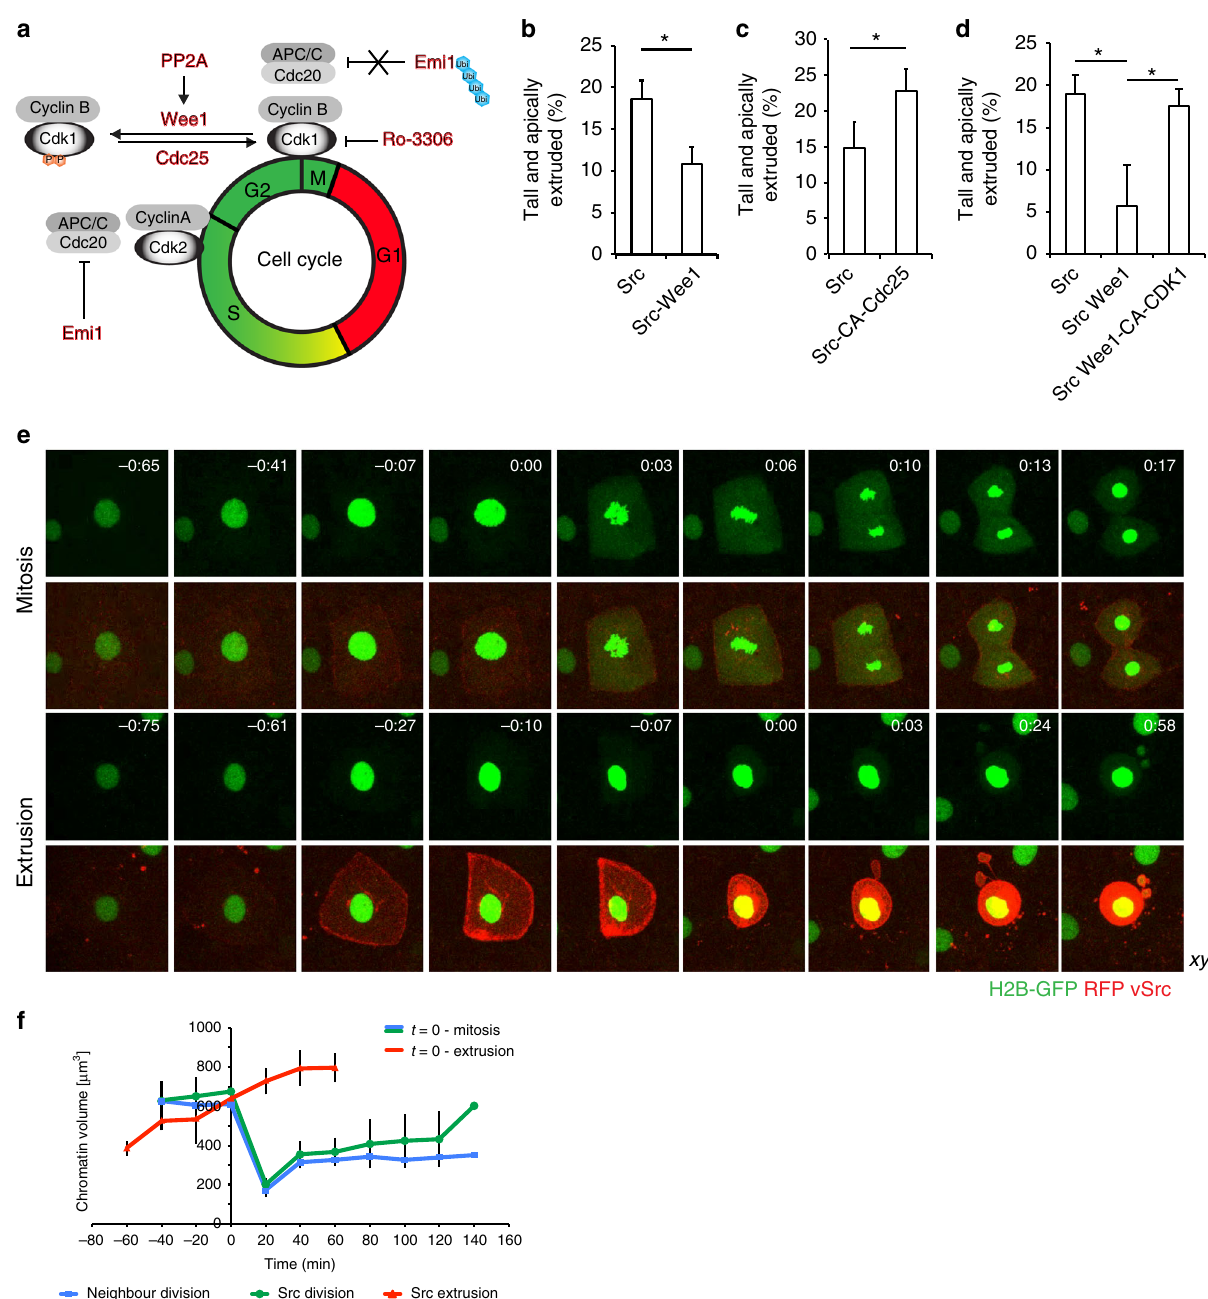
Fig. 3 vSrc-transformed cells extrude in early mitosis. a A schematic model of cell cycle regulation. Highlighted in red are the molecules whose roles in cell extrusion were tested in this work. b The effect of Wee1 expression on vSrc-driven extrusion. Embryos were injected with the following constructs: dUAS: EGFP-vSrc and dUAS:EGFP-vSrc;Wee1. Data represent the number of tall and extruded cells divided by the total number of GFP-positive cells. Data are mean ± s.d. of three independent experiments (total number of embryos: n Src = 21; n Src,Wee1 = 27). * P < 0.05 (Student ’ s t -test). c The effect of constitutively active Cdc25 on vSrc-driven extrusion. Embryos were injected with the following constructs: dUAS:EGFP-vSrc and dUAS:EGFP-vSrc;CA-Cdc25. Data are mean ± s.d. of three independent experiments (total number of embryos: n Src = 18; n Src,Cdc25 = 21). * P < 0.05 (Student ’ s t-test). d Constitutively active Cdk1 rescues Wee1 inhibition of vSrc-driven extrusion. Embryos were coinjected with the following constructs: dUAS:EGFP-vSrc alongside either dKrt18:myr- Cherry, dKrt18:Cherry-Wee1 or dKrt18:Cherry-Wee1;CA-Cdk1. Data are mean ± s.d. of three independent experiments (total number of embryos: n Src = 30; n = 29; n = 33). * P < 0.05 (Student ’ s t -test). e Time-lapse imaging of H2B-GFP in mitosis (top panel) and extrusion (bottom panel). Embryos Src,Wee1,Cdk1 were injected with the dUAS:myr-Cherry-vSrc;H2B-GFP construct. Movies were taken over 4 h and frames were extracted from a representative movie. t = 0 indicates either the beginning of mitosis (chromatin condensation) or the moment of extrusion. Scale bars, 10 µ m. f Quanti fi cation of the chromatin volume (de fi ned as the volume that H2B-GFP signal occupies in space) measured using the surface function of Imaris. The blue line follows chromatin volume change over time in a dividing EVL cell expressing myr-Cherry (averaged data from 3 cells), the green line — in a dividing vSrc cell (averaged data from 4 cells), the red line — in a extruding vSrc cell (averaged data from fi ve cells). Error bars represent